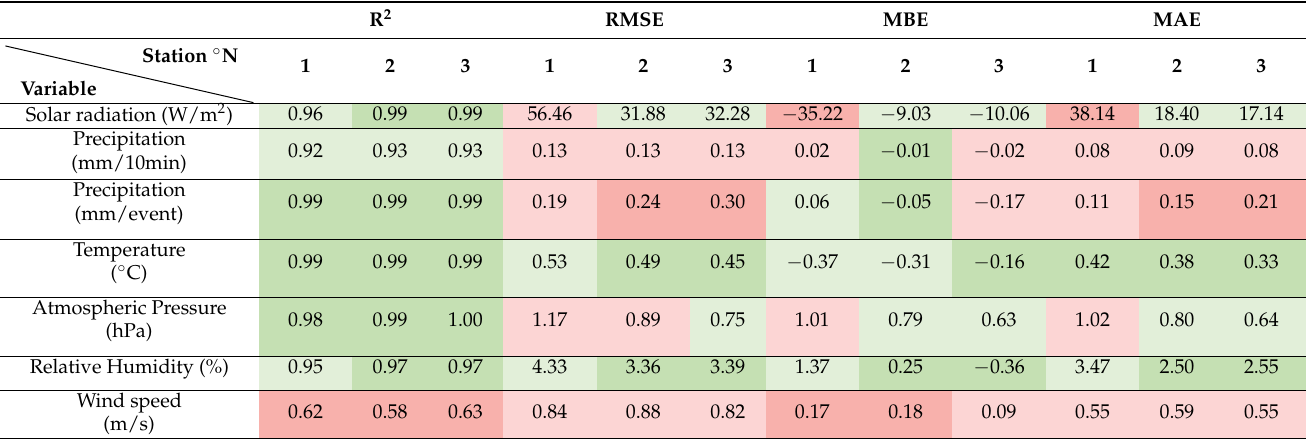
Table 4. Statistical summary of the performance of three ATMOS41 stations compared to the ICOS-bkp or Vaisala reference station. Colours give an evaluation of the comparison, with red indicating the lowest and green the highest performance. R